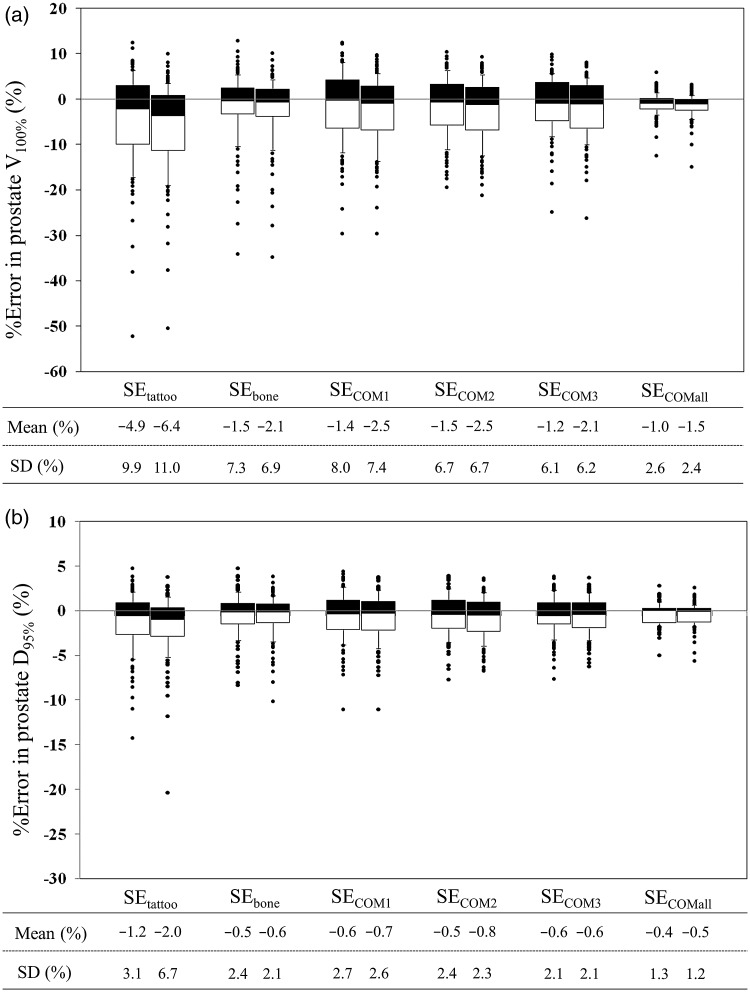
Interfractional variation in prostate (a) V100% and (b) D95%. Data are shown in percentage points. In each set-up correction policy, the left and right box plots show data in the PTV8/5 and PTV5/5 groups, respectively. Dose analysis parameters are graphically presented in box plots (showing medians, and 25th and 75th percentiles) with whiskers (10th and 90th percentiles); outliers are shown as dots.